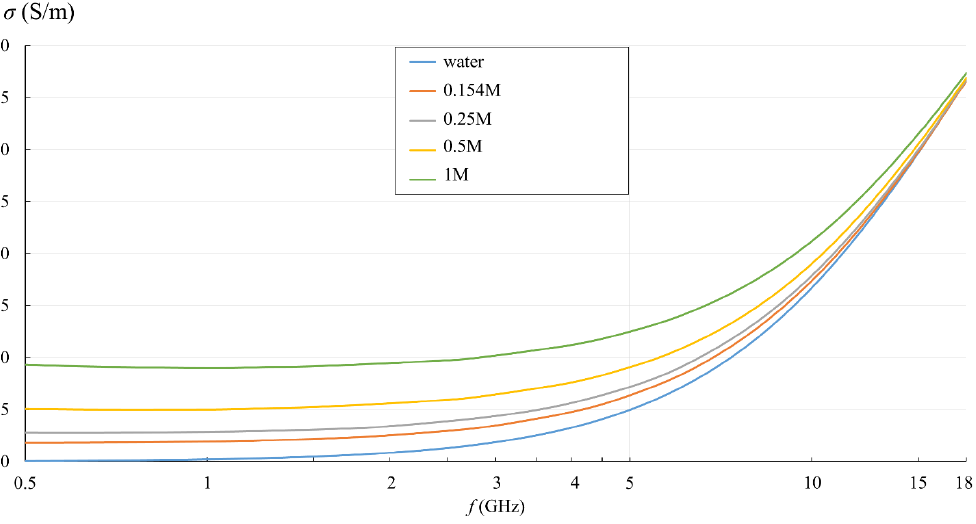
Figure 6. Measured σ of water and saline solutions, calculated from 𝜀 r″ (frequency in logarithmic scale) .